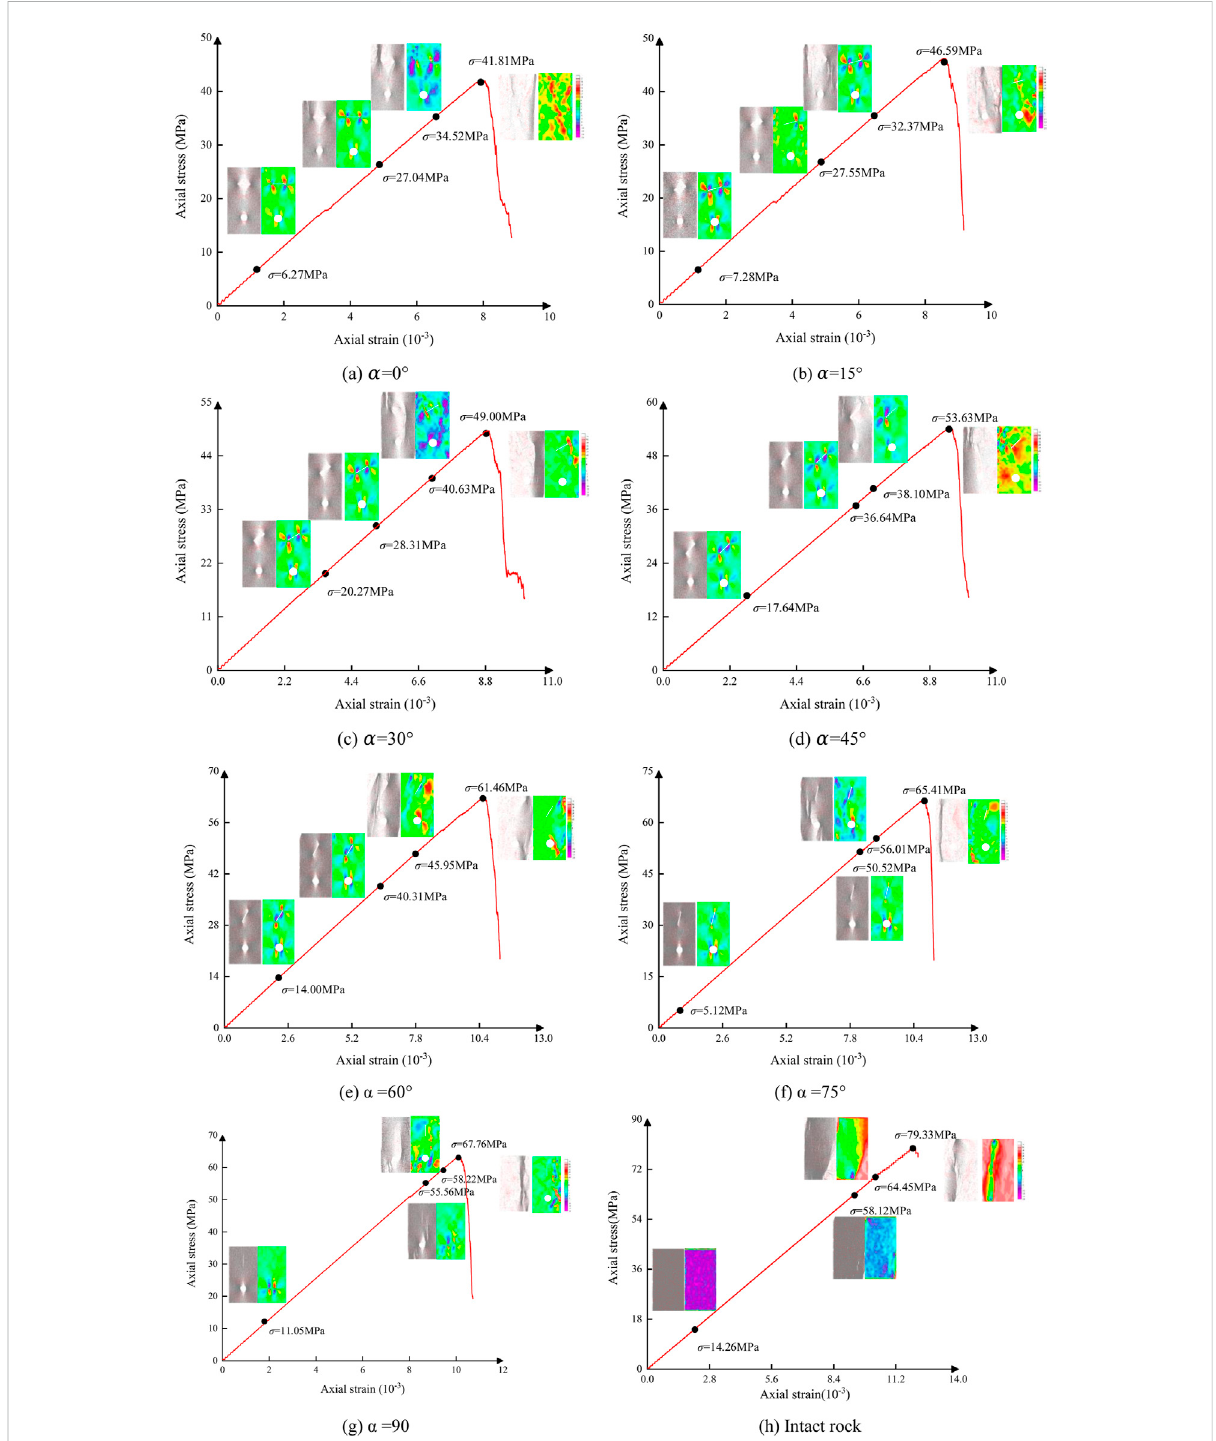
FIGURE 9 Contactforcechainandstressevolutionresultsofintactrockmodelandfracturedrockmodelwithdifferentangles. (A) α =0 ° , (B) α =15 ° , (C) α = 30 ° , (D) α = 45 ° , (E) α = 60 ° , (F) α = 75 ° , (G) α = 90, (H) Intact